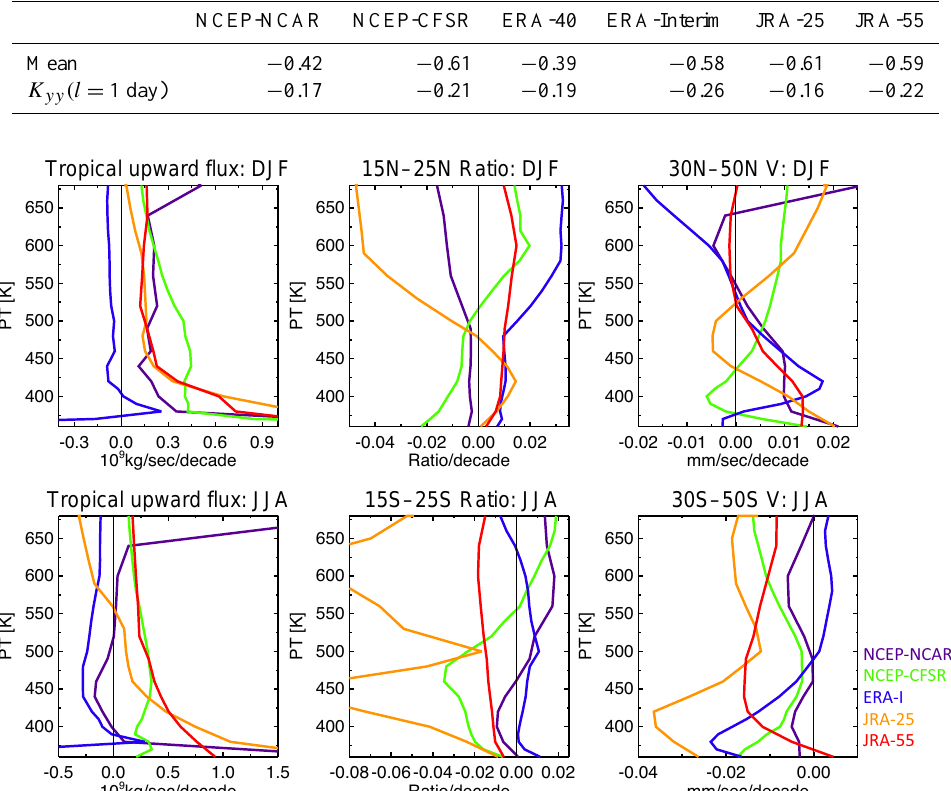
Figure 11. Vertical profiles of the linear trend of the tropical upward mass flux (left, in 10 10 kgs − 1 decade − 1 ), relative contribution of the eddy transport to the total meridional transport averaged over 15–25 ◦ (second left, in decade − 1 ), and the mean-meridional velocity v ∗ averaged over 30–50 ◦ (ms − 1 decade − 1 ) during DJF in the NH (upper panels) and during JJA in the SH (lower panels) for the 34 years,